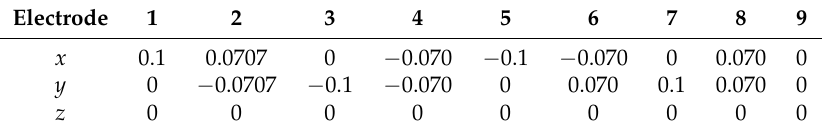
Table 1. Position of receiving electrodes for uniform circular electrode configuration (unit: m).